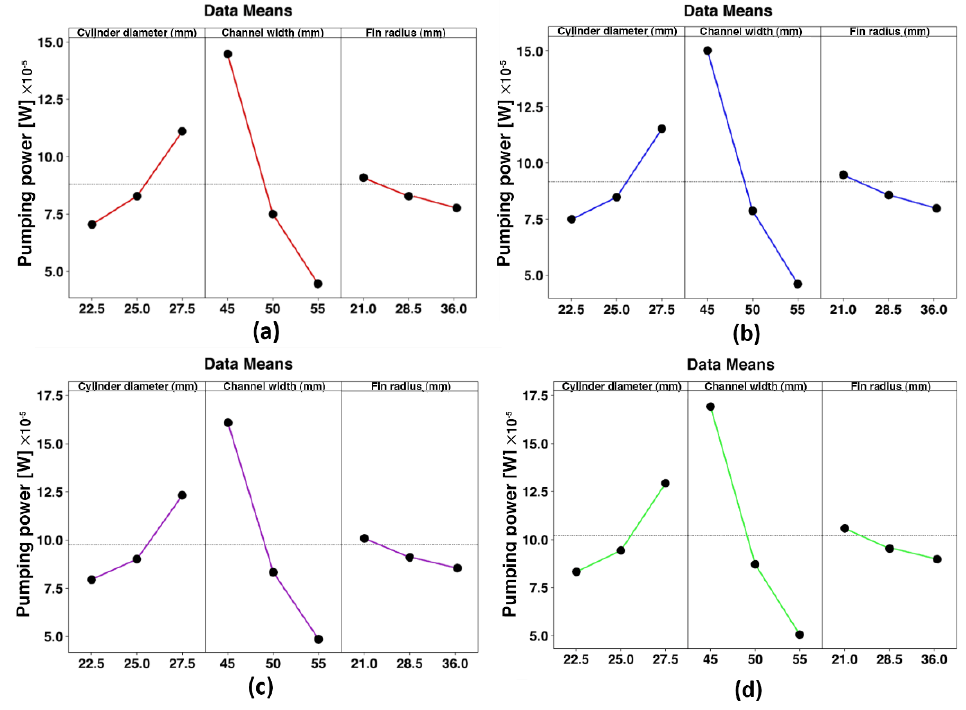
Figure 11. Main e ff ects plots for the pumping power. ( a ): ϕ = 0%, ( b ): ϕ = 1%, ( c ): ϕ = 3%, ( d ): ϕ = 5%. Figure 11. Main effects plots for the pumping power. ( a ): φ = 0%, ( b ): φ = 1%, ( c ): φ = 3%, ( d ): φ = 5%. Table 10. Predicted candidate points provided by the response surface